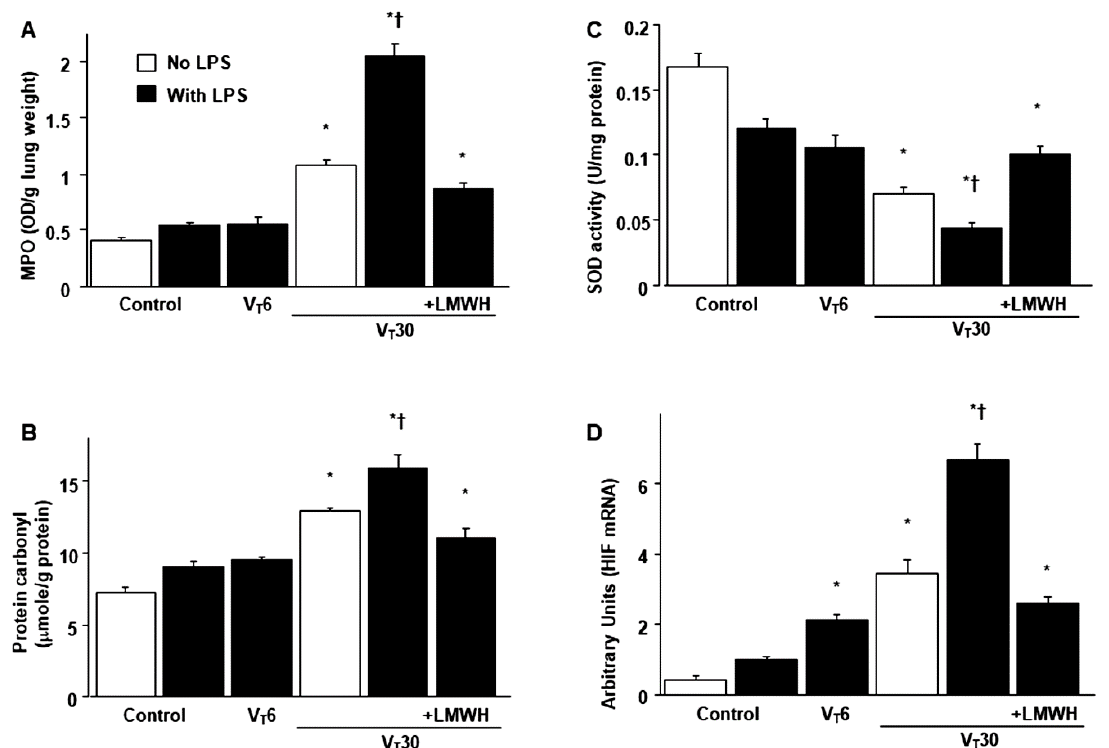
Figure 3. Reduction of endotoxin-exacerbated mechanical ventilation-mediated neutrophil influx, oxidative stress and HIF-1 α mRNA expression by enoxaparin. ( A ) MPO activity, ( B ) protein carbonyl groups and ( C ) SOD from the same animals were from the lungs of nonventilated control mice and those subjected to a tidal volume of 6 or 30 mL / kg for 5 h with or without LPS administration ( n = 5 per group). ( D ) Real-time polymerase chain reaction of HIF-1 α mRNA expression was from the lungs of nonventilated control mice and those subjected to a tidal volume of 6 or 30 mL / kg for 5 h with or without LPS administration ( n = 5 per group). Arbitrary units were expressed as the ratio of HIF-1 α mRNA to GAPDH ( n = 5 per group). Enoxaparin, 4 mg / kg, was given subcutaneously 30 min before mechanical ventilation. * p < 0.05 versus the nonventilated control mice with LPS treatment; † p < 0.05 versus all other groups. GAPDH = glyceraldehydes-phosphate dehydrogenase; MPO = myeloperoxidase; SOD = sodium dismutase.